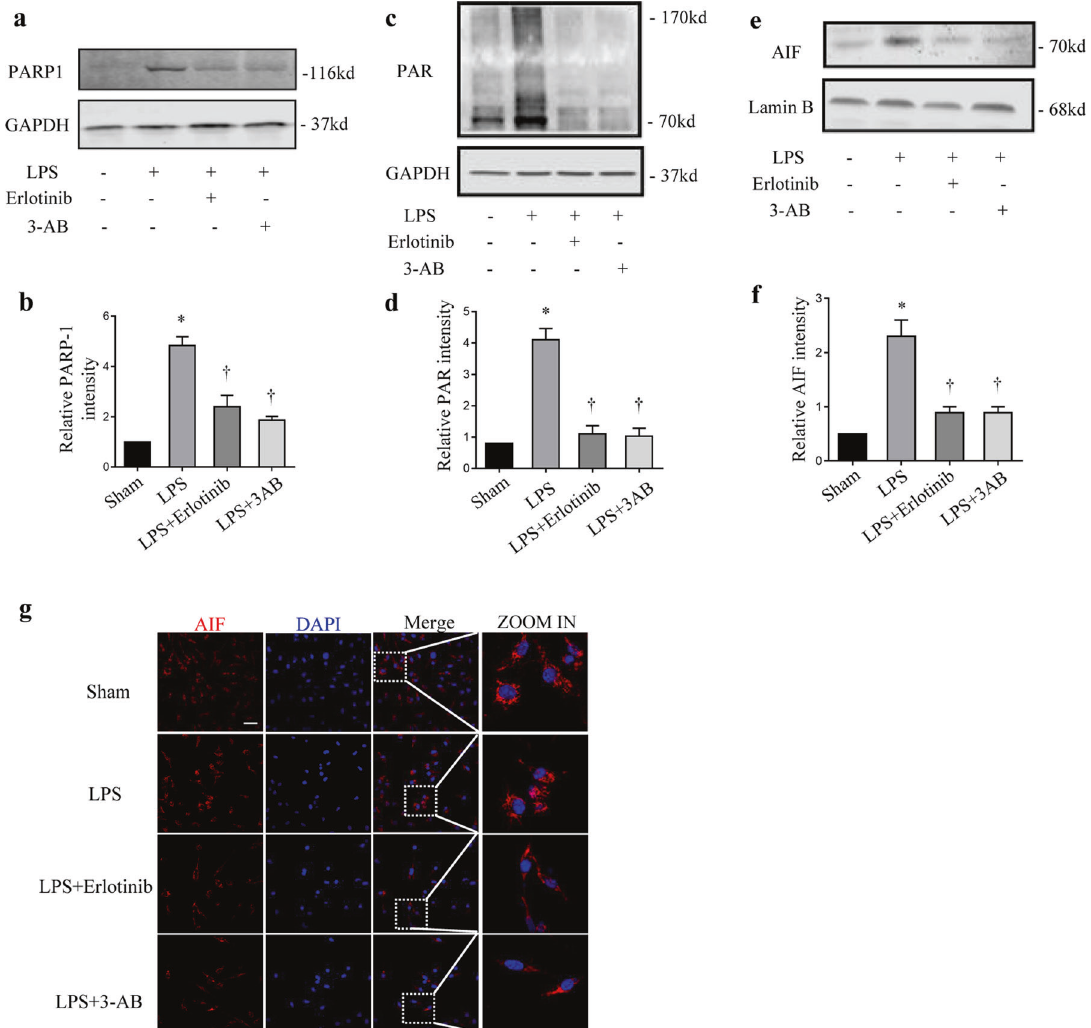
Fig. 2 Effect of erlotinib on LPS-induced parthanatos. Macrophages collected from peritoneal lavage at 24 h after pretreated with erlotinib or 3-AB with LPS treatment. a , c Immunoblotted for PARP-1 activation, PAR formation, and GAPDH. b , d Mensuration of PARP-1 ( b ) and PAR ( d ) expressions. e Immunoblot analysis of AIF and Lamin B amount in nuclei. f Mensuration of AIF expression in nuclei. g Fluorescence images depicting AIF translocation (up panel; scale bar, 100 μ m). Error bars represent SD ( n = 3). * P < 0.05 as compared with NC; † P < 0.05 as compared with LPS